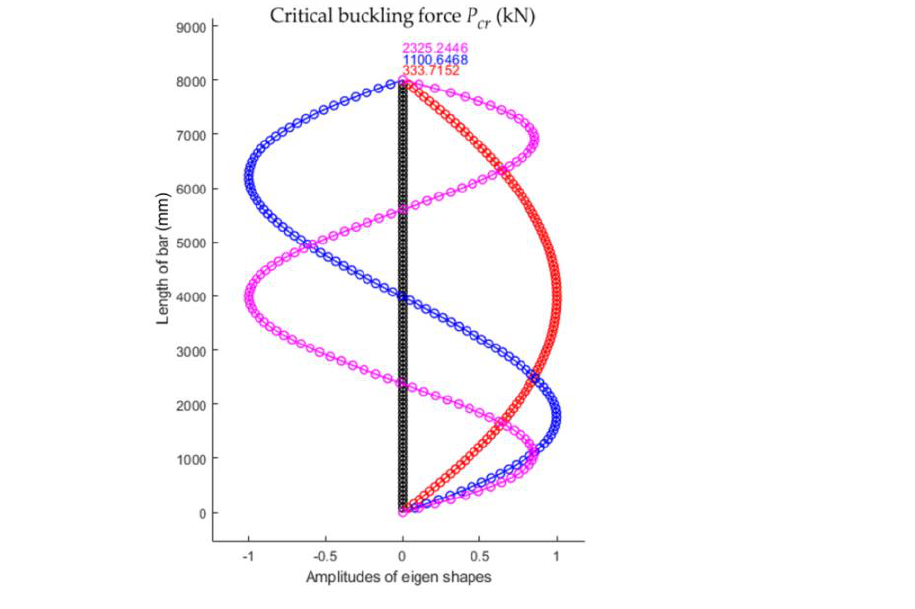
Figure 21. The first three shapes of stability loss and corresponding values for the critical buckling force for the bar with trapezoidal variation in the second moment of inertia along the bar axis.